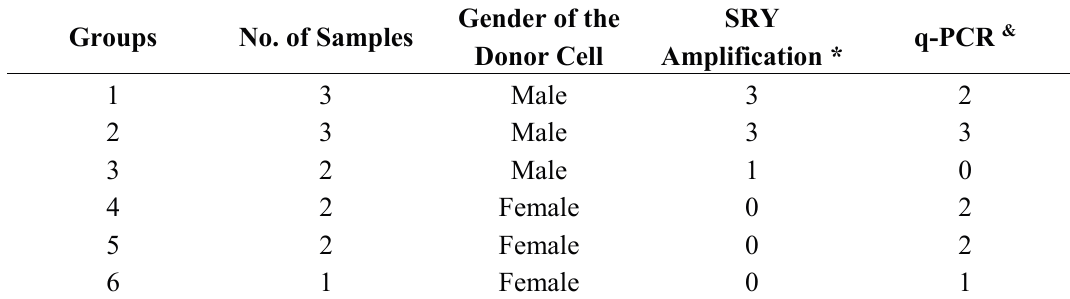
Table 1. Collection and analysis of the aborted porcine